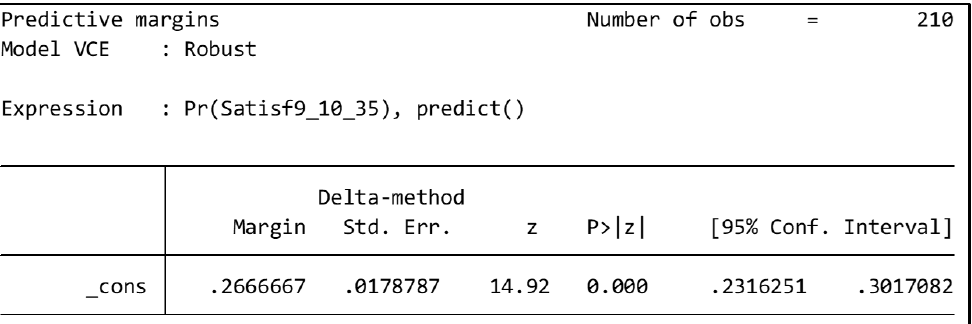
Figure 2. Predictive Margins Model 1.